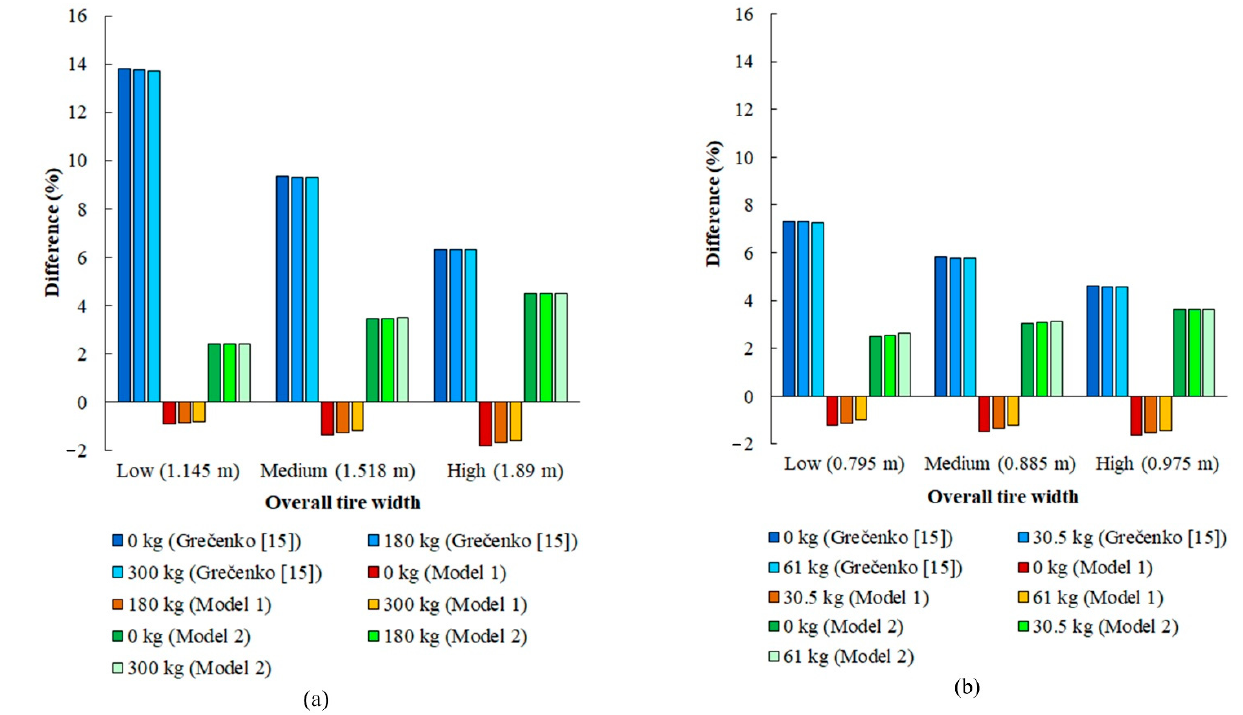
Figure 13. Comparison of [14] with [15], Model 1, and Model 2: ( a ) Universal tractor; ( b ) Subcompact tractor. Comparing [14] with Model 2, differences decreased in both tractors. The highest differences were observed in the universal tractor (4.48%, 4.49%, and 4.50%) and subcompact tractor (3.63%, 3.62%, and 3.61%) with high overall tire width. Model 1 showed the highest differences in the universal tractor ( − 1.81%, − 1.68%, and − 1.60%) and subcompact tractor (1.63%, 1.54%, and 1.42%) at high overall tire width. The minus sign means higher values of static overturning angles calculated according to [15] than [14]. The results mentioned above showed that the difference was decreased in Model 2 and Model 1. In the case of Model 1, the difference is relatively small (<1.81%) and not dangerous for practical conditions considering the safety factor standardly used to ensure tractor operation under safe conditions. In practical conditions, the calculated value of static overturning angle is multiplied by the safety factor. The safety factor is the number which decreases the calculated static overturning angle to eliminate calculation errors caused, for example, by different tire deformations and other undesirable effects.